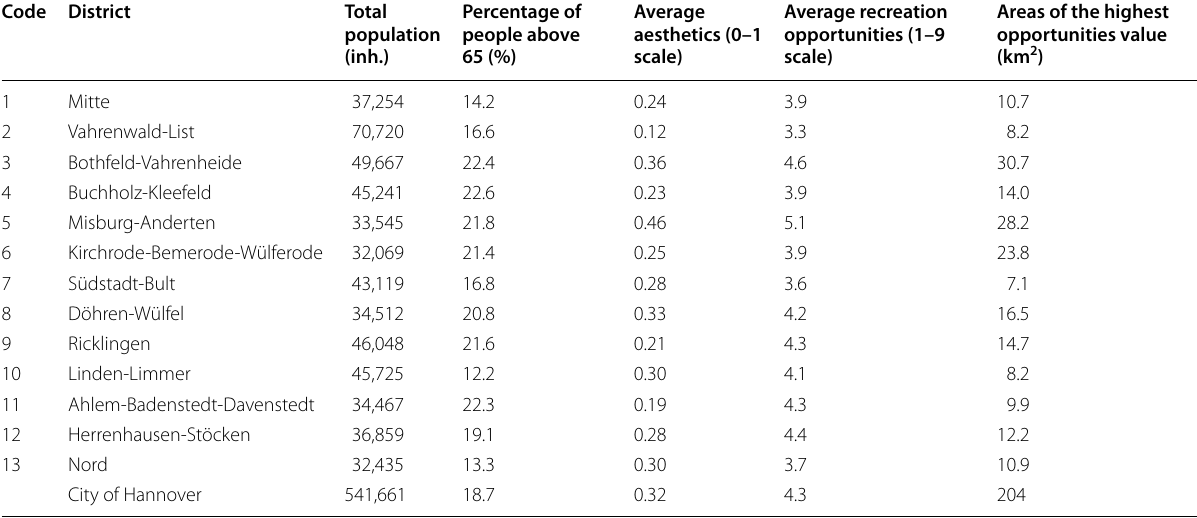
The highest opportunities have the value 9 in the opportunity map The population data are from the City of Hannover in 2018. For a detailed evaluation of equality in access considering elderly people’s mobility, see Wen et al. (2020)